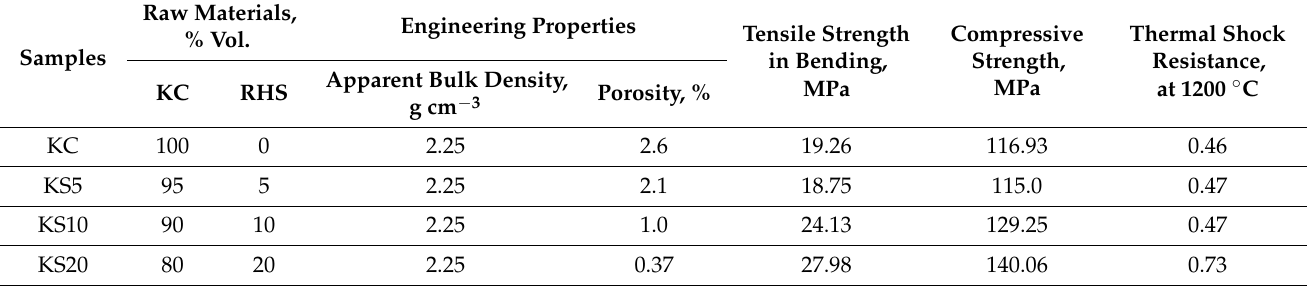
Table 4. Composition and properties of KC/RHS-based refractory. Data from [13].